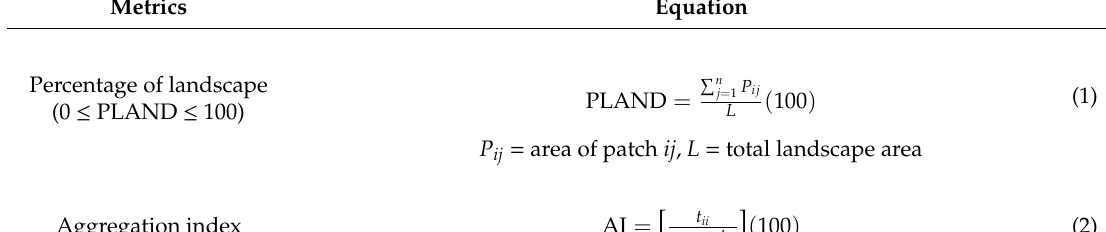
Table 1. Landscape metric equations used to detect spatial patterns of urbanization. Metrics